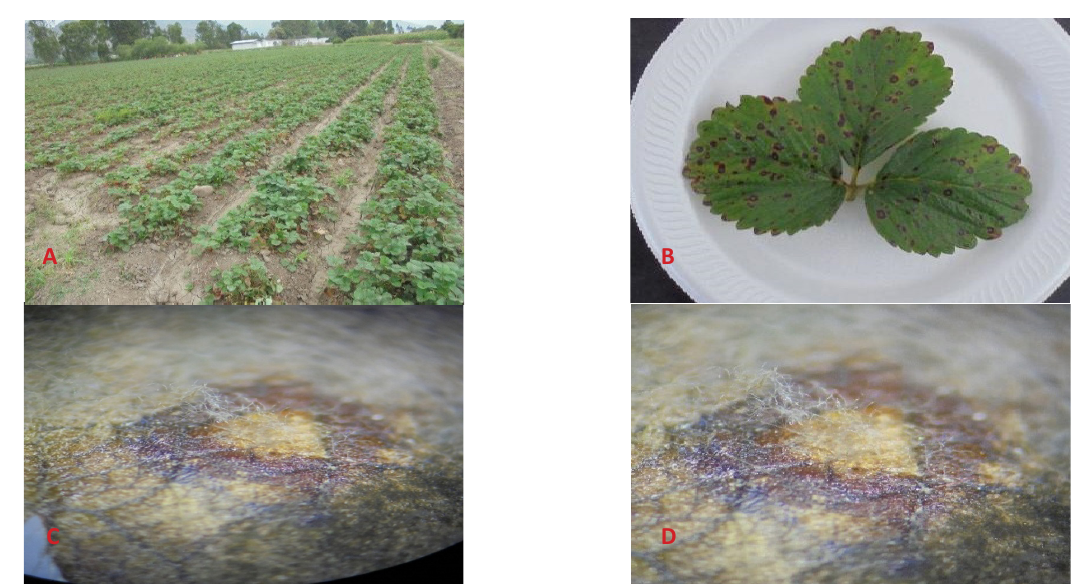
Figure 1. Leaf spot in strawberry ( Fragaria ananassa ) plants. A) Strawberry field infected with leaf spot. B) Leaves exhibiting symptoms of leaf spot. C) Symptoms of leaf spot after 15 days of incubation in a humid chamber. D) Pathogen structures developed on an area of leaf showing symptoms of leaf spot.